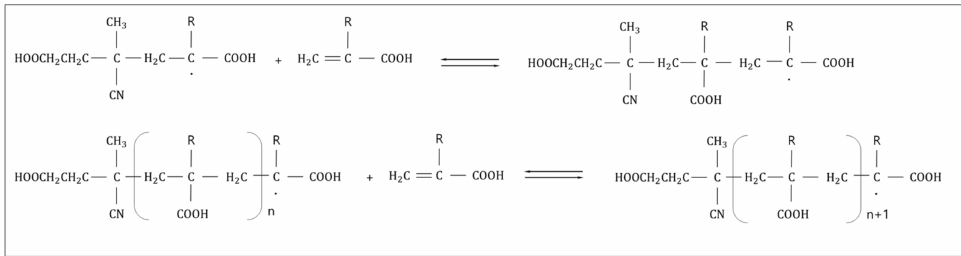
Figure 3. Radical mechanism propagation.